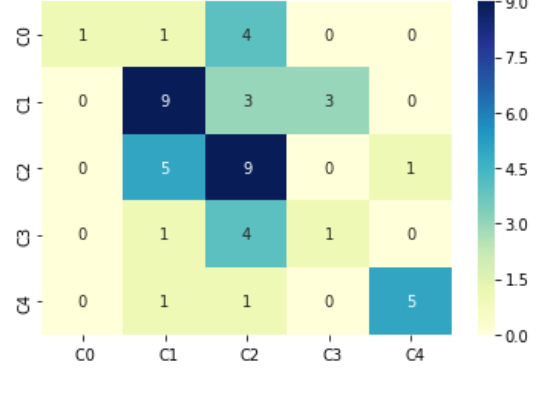
Figure 6. Confusion Matrix.